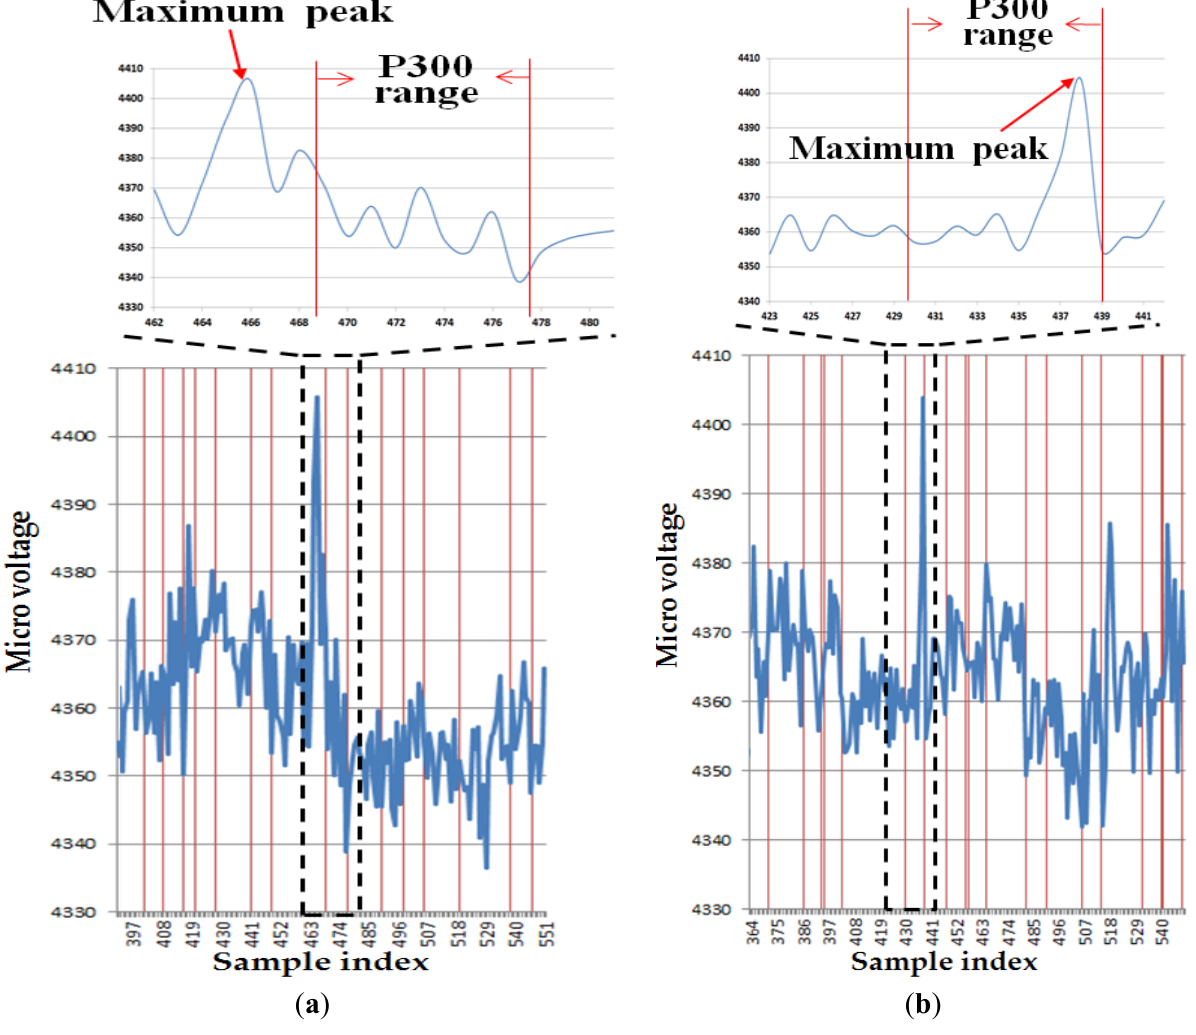
Figure 9. Examples of correct or incorrect detection of EEG signal. ( a ) The case of incorrect detection of the EEG signal because the maximum peak of the EEG signal does not belong to the P300 range (analysis in the entire area of the 12 × 12 matrix by only using the EEG signal). ( b ) The case of correct detection of the EEG signal because the maximum peak of the EEG signal belongs to the P300 range (analysis in the 3 × 3 matrix using the proposed